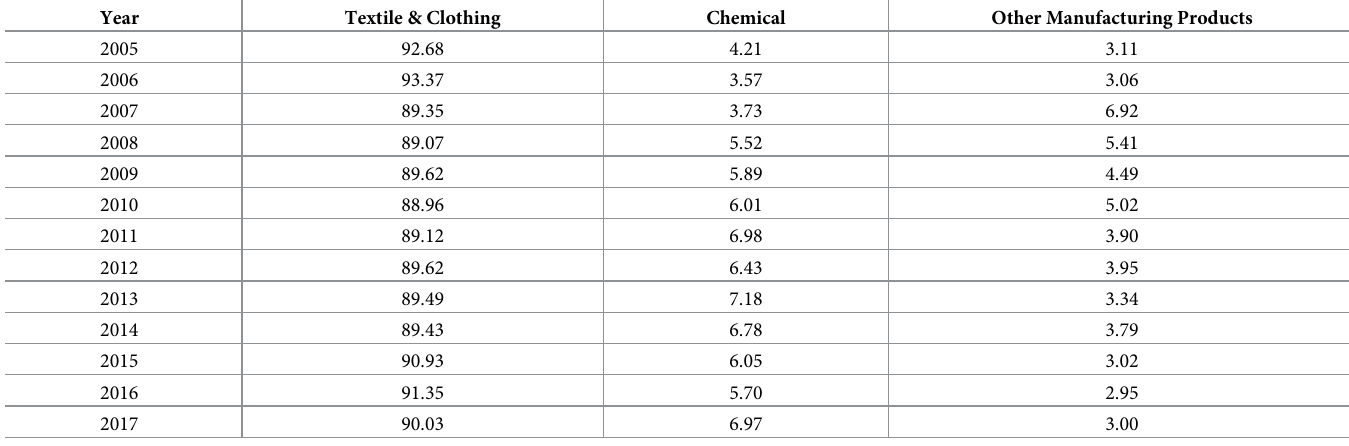
Table 1. Percentage share in total manufacturing exports.